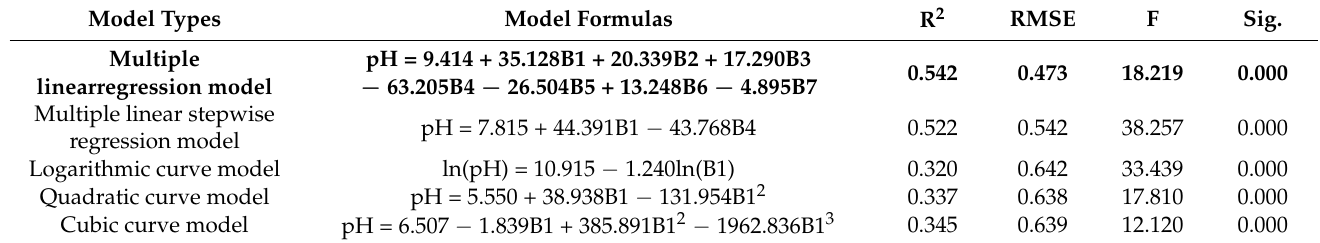
Table 2. Primary curve estimation of the soil